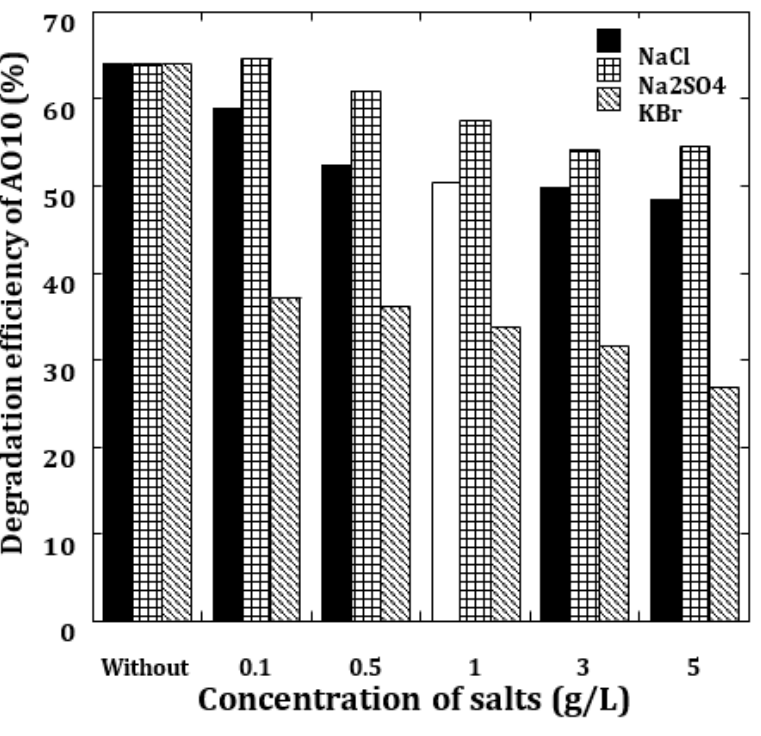
Figure 9. Effect of different salts on the degradation efficiency of AO10 ([A010] 0 = 50 mg/L, 20 ± 1 °C, [IO 4- ] = 3 mM, irradiation intensity: 15 mW/cm²).